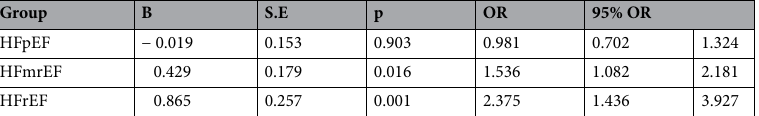
Table 4. Cox proportional hazard model of HF groups (n = 1034). Group NHF used as reference. HF heart failure, EF ejection fraction, NHF no HF, HFpEF HF with preserved EF, HFmrEF HF with mid-range EF, HFrEF HF with reduced